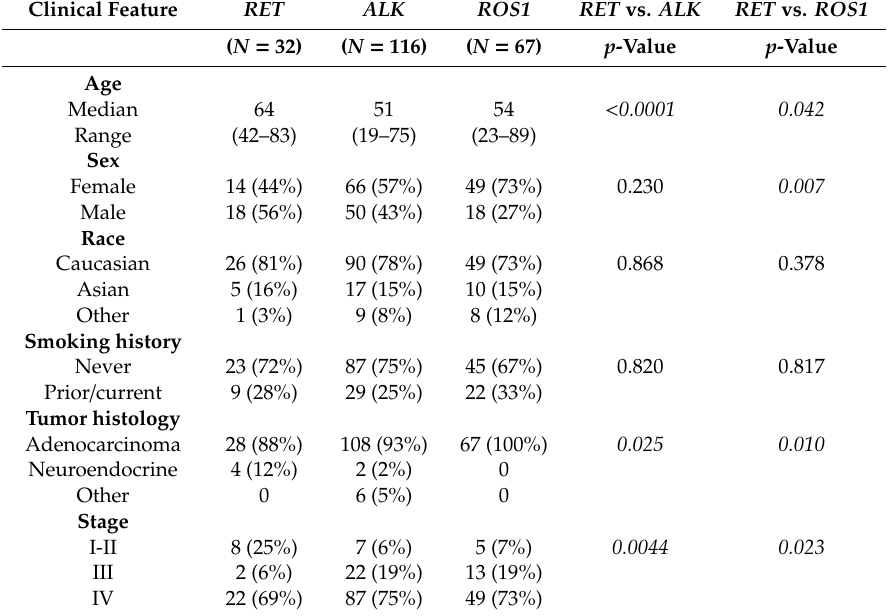
Table 1. Clinicopathologic features of patients with RET , ALK , and ROS1 fusion-positive